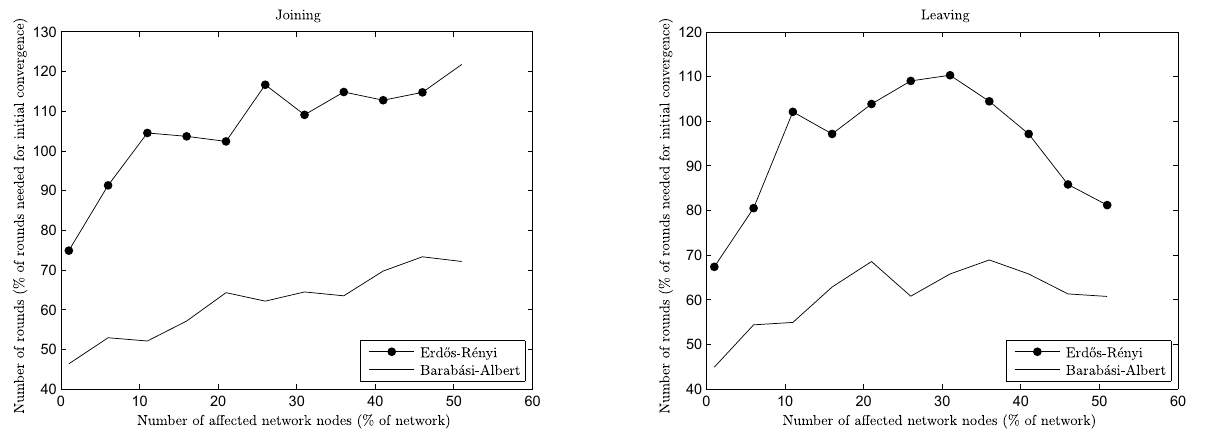
Figure 4. Reconvergence speed per operation, joins/leaves, n = 1 , 000